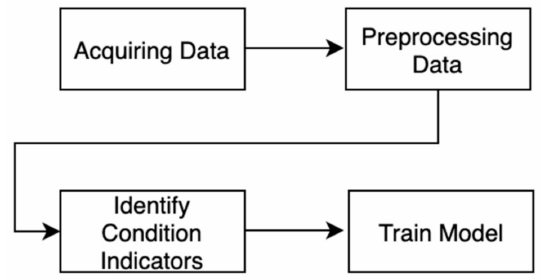
Figure 5. Predictive maintenance workflow.